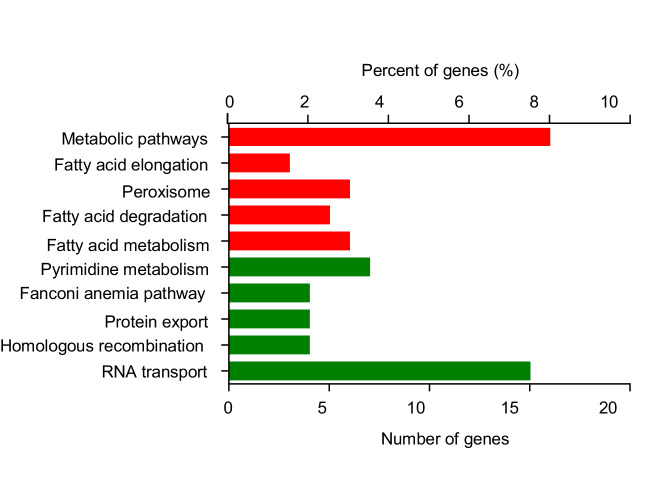
KEGG pathway analysis of differentially expressed genes upon HFD feeding.Wild-type virgin female flies were fed with ND or HFD for 5 d before their head tissues harvested and subjected to RNAseq. The highly influenced KEGG pathways were shown (red: up-regulated by HFD; green: down-regulated by HFD).